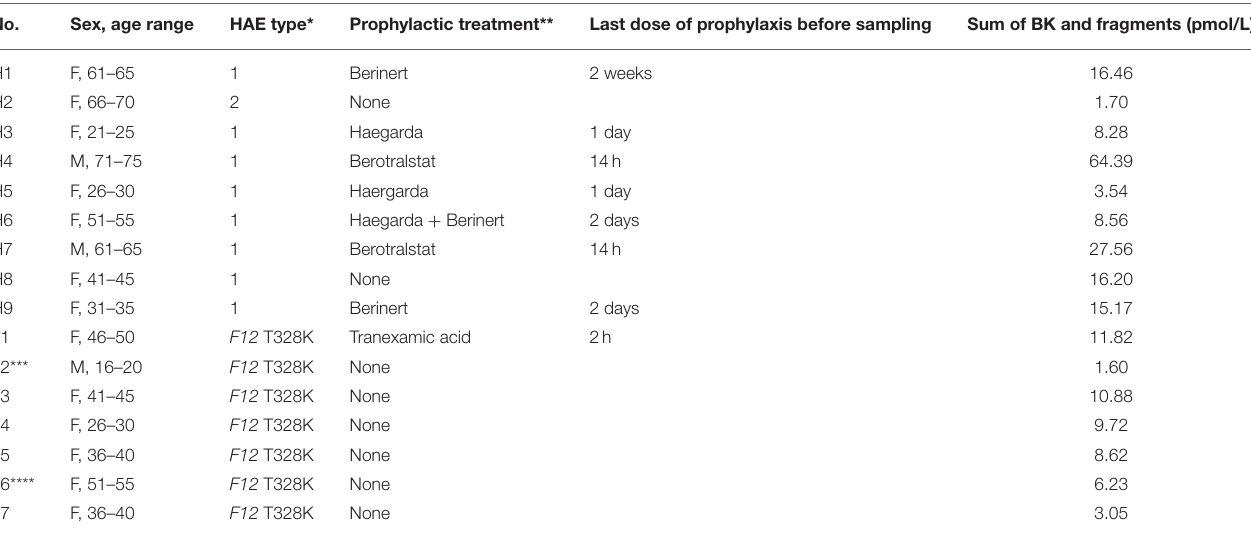
TABLE 2 | Characteristics of patients with HAE.